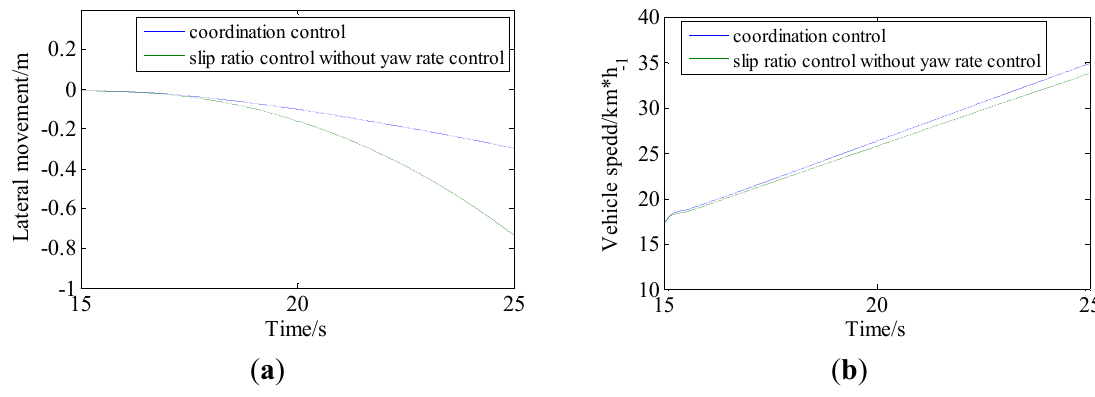
Figure 18. Experiment results of acceleration slip regulation on variation friction coefficient road: ( a ) slip ratios of driving wheels; ( b ) yaw rate of vehicle; ( c ) torque commands of slip ratio control and yaw rate control; and ( d ) motor torque outputs.